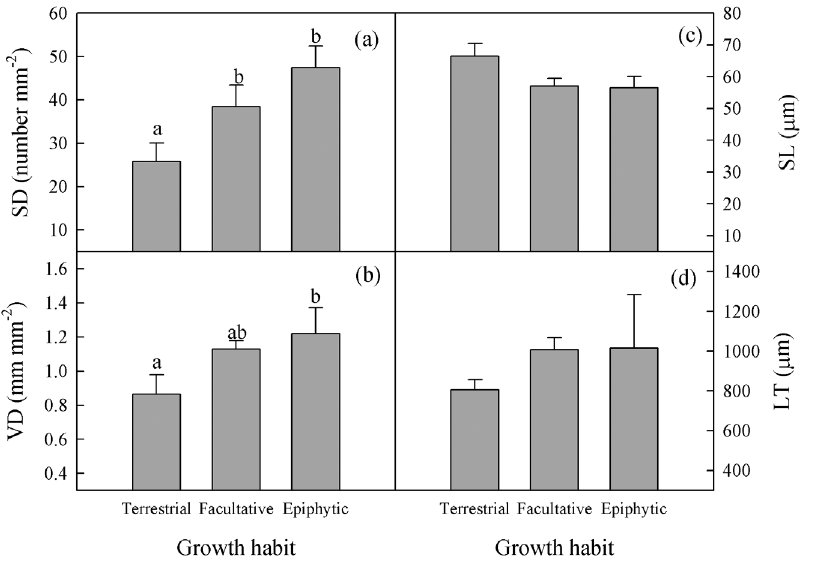
Figure 2. Differences in stomatal traits and leaf thickness of Paphiopedilum due to growth habit. SD, stomatal density; VD, vein density; SL, stomatal length; and LT, leaf thickness. Different letters above bars for each component indicate statistically different mean values ( p # 0.05), as determined by LSD multiple comparison tests.